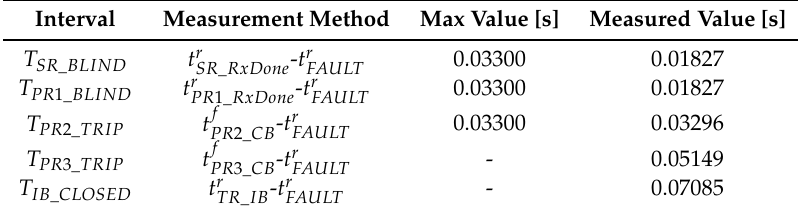
Table 13. Time intervals for fault clearing and interconnection reclosure for the fault 50.S3. Case Study Interval Measured Value [s] Fault clearing time for fault 50.S3 between SR and PR1 T SR _ TRIP 0.03297 Fault clearing time for fault 50.S3 between PR2 and PR3 T PR 2_ TRIP 0.03296 Reclosure time for fault 50.S3 between SR and PR1 T IB _ CLOSED 0.10796 Reclosure time for fault 50.S3 between PR2 and PR3 T IB _ CLOSED 0.07085